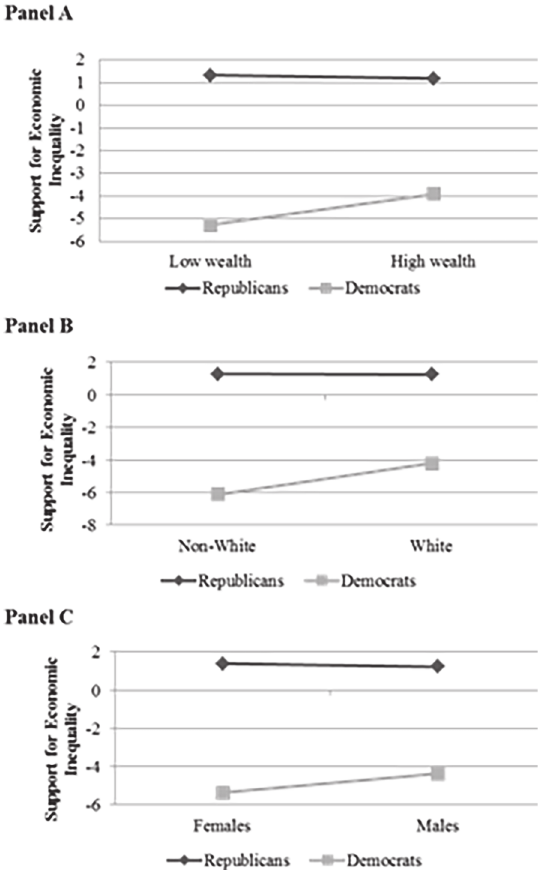
Figure 1. Relationships between social status and the tendency to sponsor legislation supporting economic inequality. Social status is measured in terms of average wealth (Panel A), race (Panel B), and gender (Panel